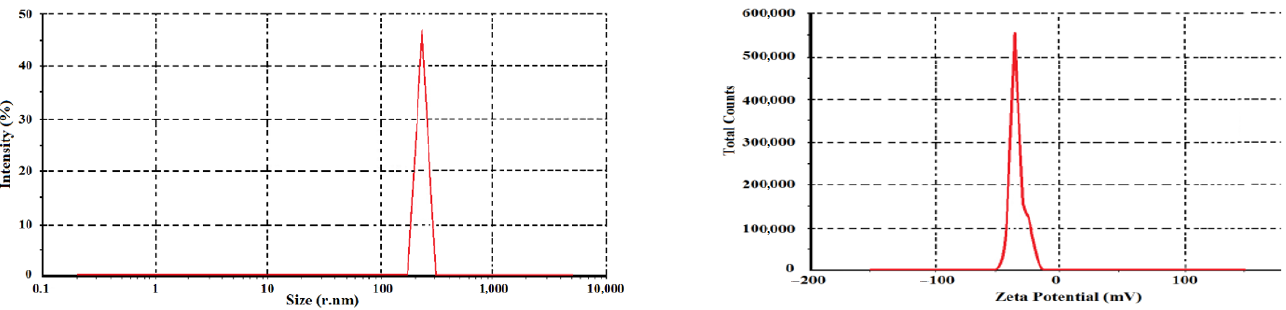
Figure 6. Distribution pattern of erythromycin ‐ loaded PLGA nanoparticles. After loading the antibiotic onto PLA/PLGA matrix, erythromycin ‐ loaded PLA na ‐ noparticles were recorded around 325 nm in size, while drug ‐ loaded PLGA nanoparticles were recorded approximately 258 nm in size, depending on the initial antibiotic concen ‐ tration. Electro ‐ kinetic potential measured at the exterior side of the colloidal nanostruc ‐ tures indicated zeta potential values of drug ‐ loaded polymer nanoparticles of − 11.3 mv for PLA and − 17.3mv for PLGA, respectively, which denoted the degree of rejection of similarly charged particles in dispersion. A higher zeta potential for nanoparticles indi ‐ cates the stability of colloidal dispersions resisting nanoparticles aggregation. HPLC chromatograms are presented in Figure 7. It can be seen from the chromato ‐ gram of the samples that the retention times of erythromycin are approximately the same as the retention times of erythromycin in the reference chromatogram. The percentage content of erythromycin A was calculated using the chromatogram shown in Figure 7a, as a reference, and the percentage content of erythromycin B using the chromatogram shown in Figure 7b, as a reference. The amount of erythromycin pro ‐ pionate in both samples was expressed as the sum of erythromycin A and erythromycin B and was 99.7% of the initial amount used to prepare antibiotic ‐ loaded nanoparticles for both samples.